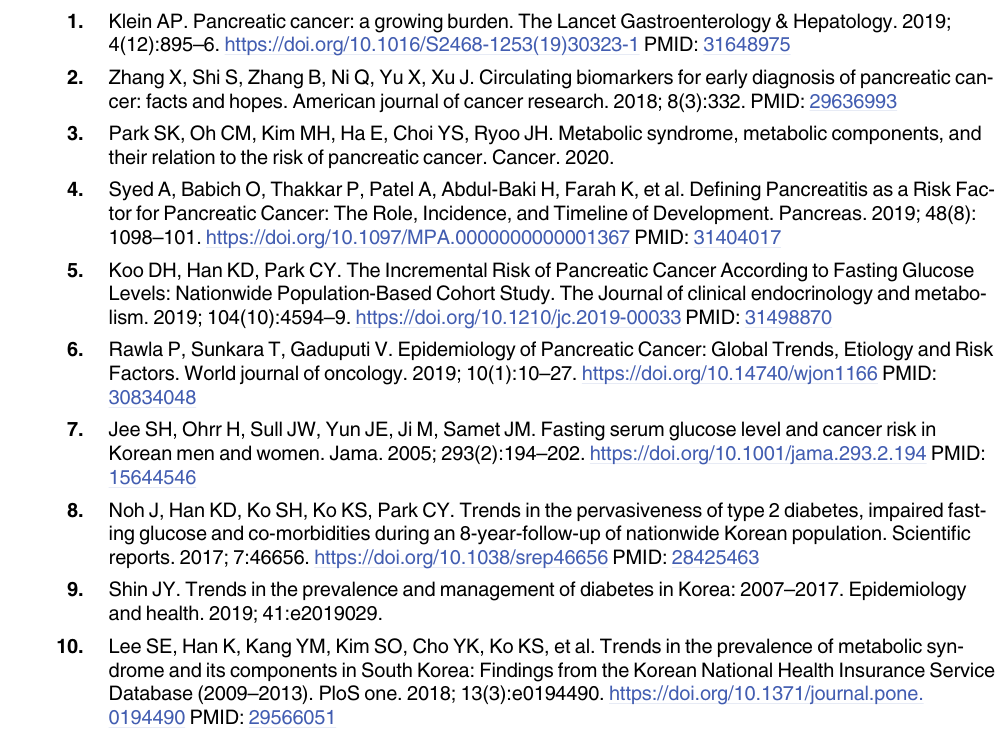
S5 Table. Hazard ratios (HRs) and 95% confidence intervals (CI) for the incidence of pan- creatic cancer according to the quartile of fasting blood glucose after excluding the possi- bility of 1-year reverse causality (N = 18,995). S1 Fig. Kaplan-Meier plot of cumulative incidence of pancreatic cancer according to the quartiles of fasting glucose.